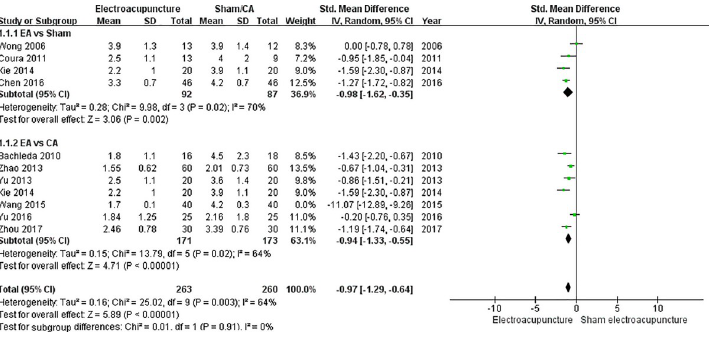
Fig 5. Final forest plot of pain score 24 hours after sensitivity